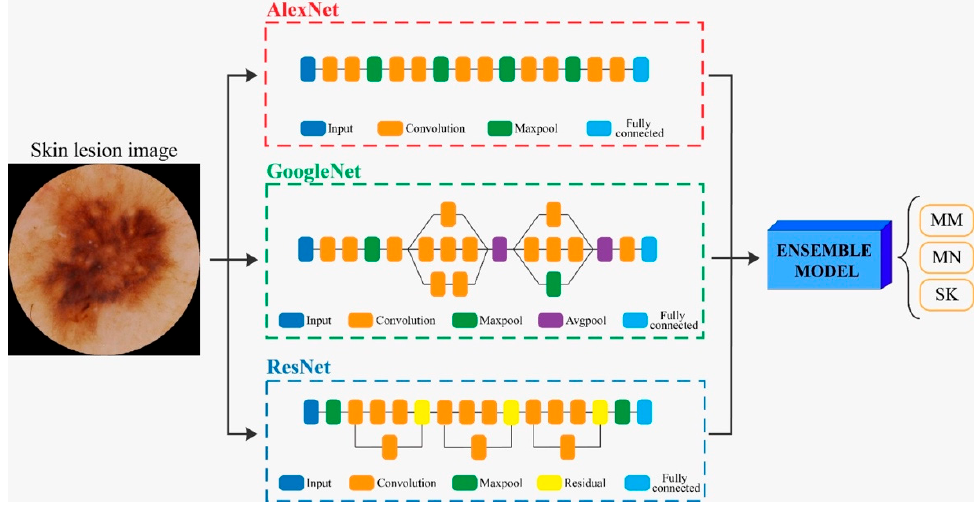
Figure 7. Flowchart for the classification of skin lesion images. Three different CNNs’ (AlexNet, GoogleNet, and ResNet) were employed for classification. Then, an ensemble model averaged all the CNNs’ predictions to obtain the final label of the image. MM: malignant melanoma, MN: melanocytic nevus, SK: seborrheic keratosis.